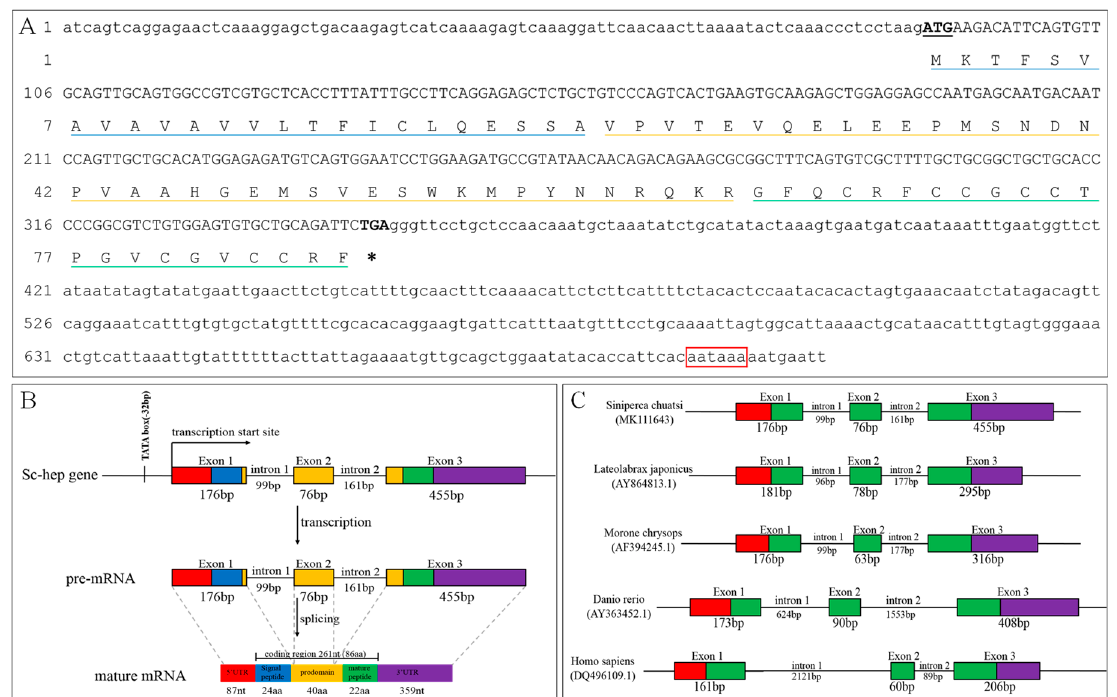
Figure 1. Sequence analysis of Sc-hep. ( A ): cDNA and deduced amino acid sequences of the Sc-hep gene. The black underline and the asterisks represent the start and stop codons, respectively. The blue, yellow, and green underlines indicate signal peptide, propeptide, and mature peptide, respectively. The red squares denote the PolyA signal. ( B ): Analysis of Sc-hep gene structure. ( C ): Comparison of vertebrate hepcidin gene structure. The boxes, lines, red regions, and purple regions represent exons, introns, 5’-UTR, and 3’-UTR, respectively. The blue, yellow, and green regions represent signal peptides, propeptides, and mature peptides, respectively.